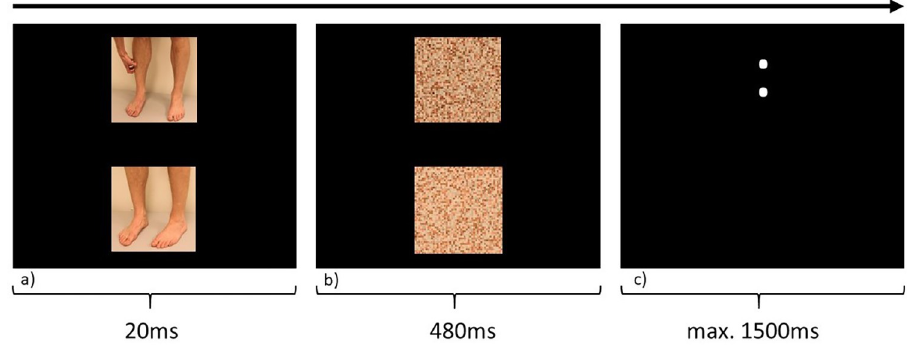
Fig 2. Dot-probe task. One trial of the subliminal Dot-Probe task showing a trial with an itch-picture and a skin- picture as control (a) with their corresponding masks (b). The target (c) is presented in the same location as the itch- picture (until button press), making this trial a congruent trial. Additionally, in the middle of the screen, a fixation cross is shown in-between trials